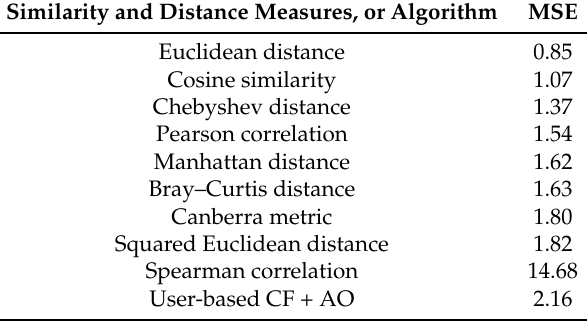
Table 7. MSE of each of the nine similarity and distance measures concentrated in the user-based CF algorithm and of user-based CF with an average aggregation operator that integrates the nine measures.